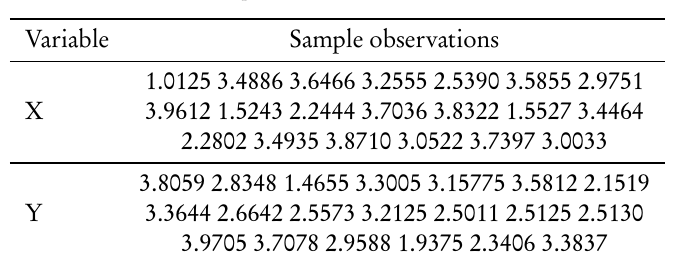
Sample observations - Case 1.